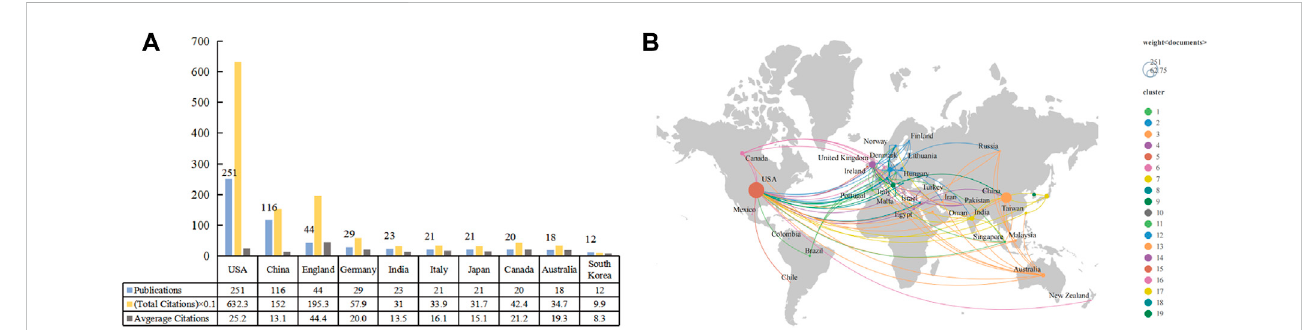
FIGURE 4 The top 10 proli fi c countries/regions and cooperative networks working on the application of stem cells for glaucoma treatment and research. (A) The number of publications, total citations, and average citations in the top 10 countries/regions. (B) The cooperative network visualization map of countries/ regions on applications of stem cells for glaucoma treatment and research. Node size indicates the number of publications.